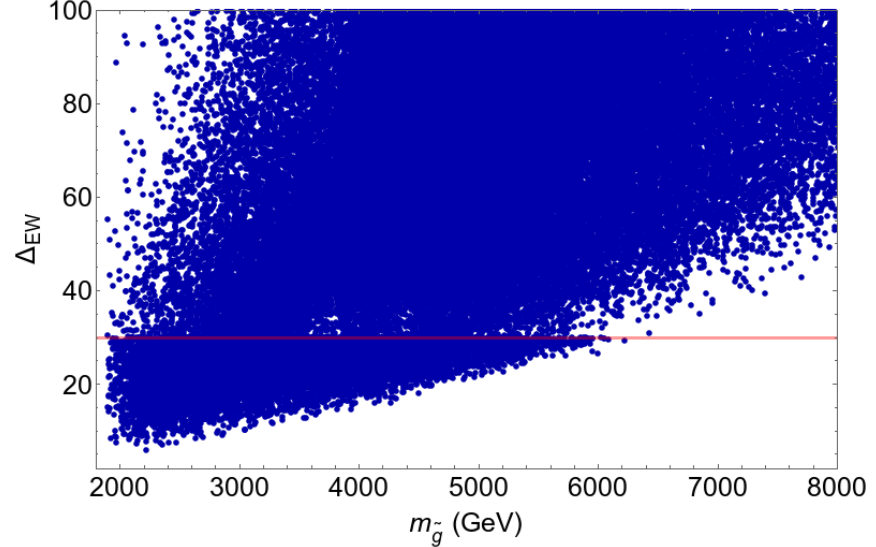
Figure 12 . Plot of (cid:1) EW vs. m ~ g from a scan over natural mini-landscape parameter space with m 0 (1 ; 2) ’ m . 3 = 2